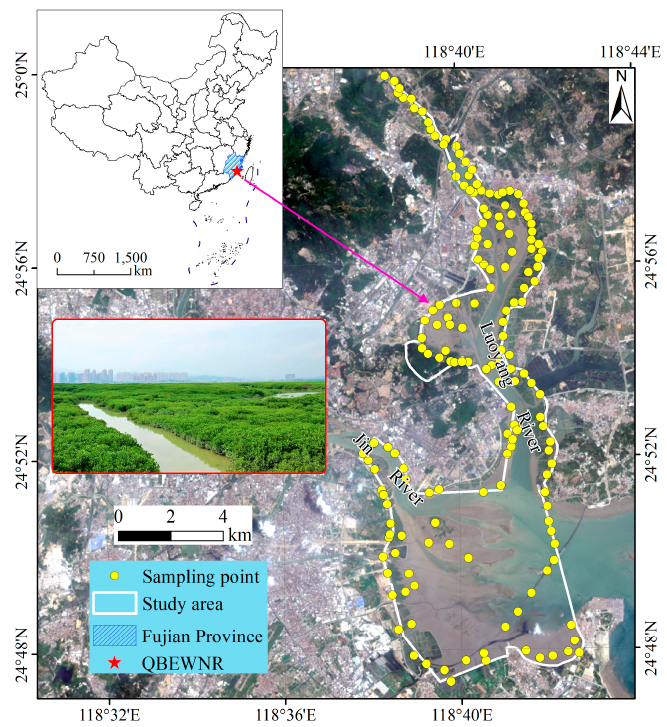
Figure 1. Location of the study area (QBEWNR represents the Quanzhou Bay Estuary Wetland Nature Reserve).